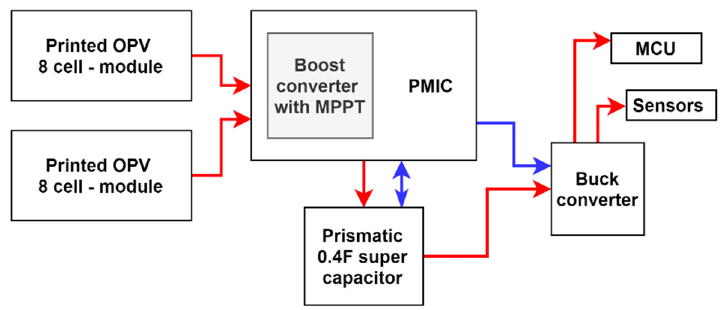
Figure 10. The structure of the designed EHU.